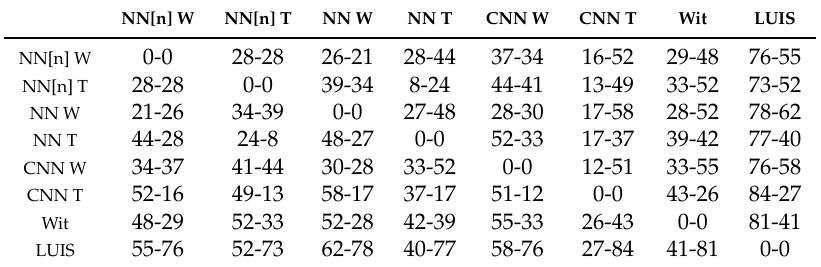
Table A2. N A and N B for pairs of models, where A is the model corresponding to the row and B is the model corresponding to the column. Models are listed in the same order as in Table 6.